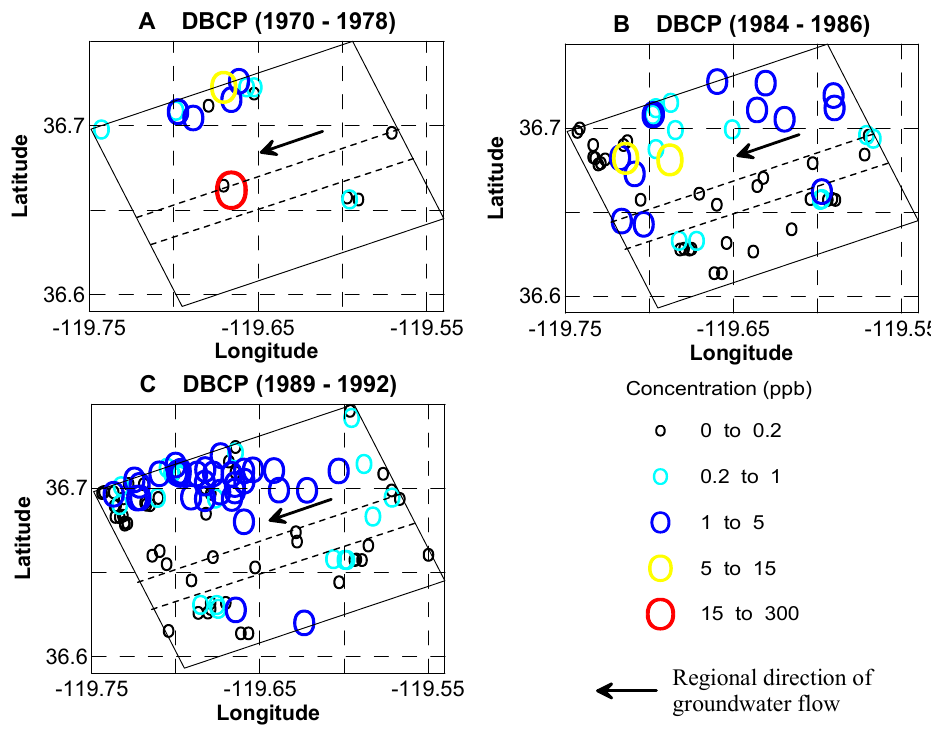
Figure 10. The measured concentration of DBCP during 1970~1978 ( A ); 1984~1986 ( B ); and 1989~1992 ( C ). The rectangle in the middle represents the surface area of the model, and the two short dashed lines give the approximated surface areas of IVF.